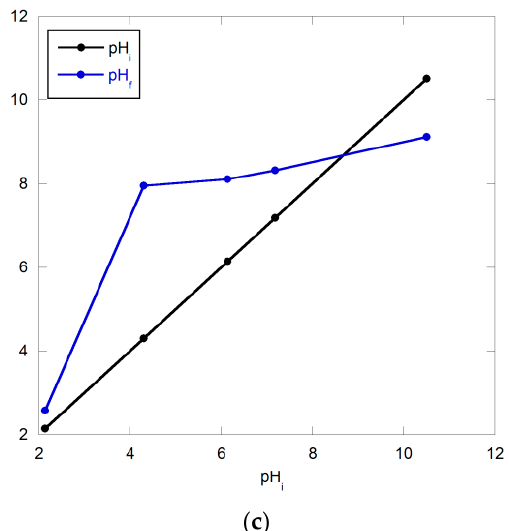
Figure 7. ( a ) Structure of the investigated anionic and cationic dyes; ( b ) adsorption capacities of